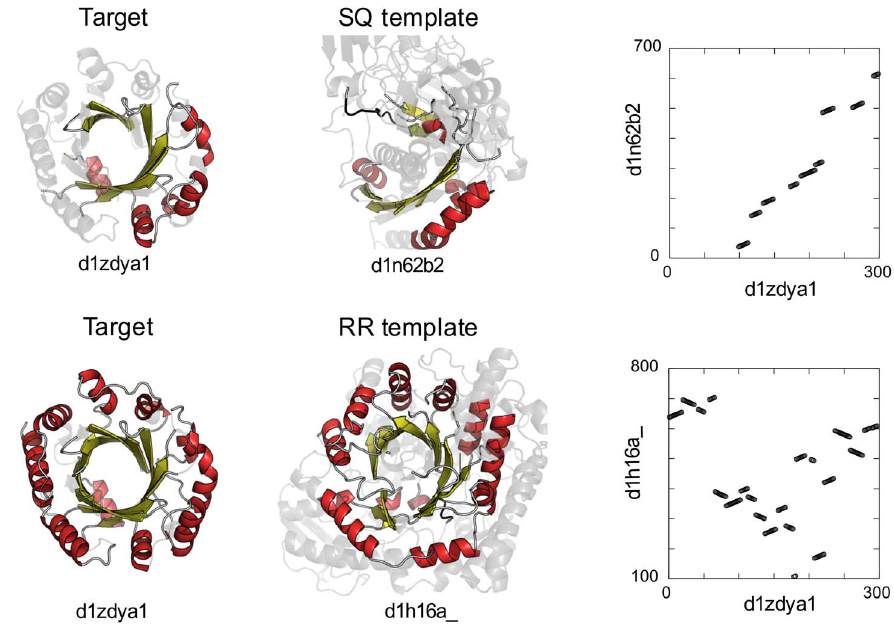
Figure 4. The SQ and RR templates of aromatic prenyltransferase. The cartoon figures on the left represent the structure of aromatic prenyltransferase, which exhibited the largest difference in TM-score between the RR and SQ templates, and those in the middle present the SQ and RR template structures. In these figures, only structurally aligned regions are highlighted and colored. The graphs on the right are the alignments plots between the target and template. doi:10.1371/journal.pone.0107959.g004 number of structural neighbors significantly increased as the N RW , and N RR , respectively, with the overline denoting average restriction of the alignment search space was relaxed from the SQ values. scheme to the RW scheme and from the RW scheme to the RR scheme. The resulting values were 2.43, 7.78, and 26.44 for N SQ ,